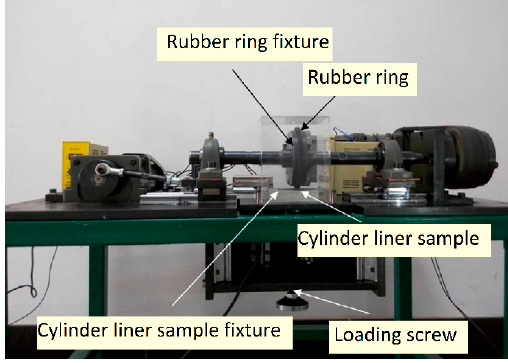
Figure 5. Mechanical honing equipment.